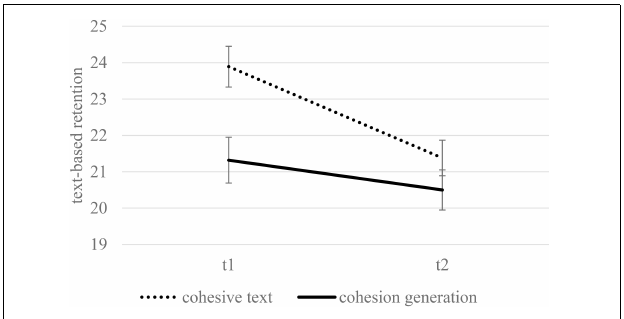
FIGURE 1 | Text based representation as a function of condition and delay when controlling for reading skills (estimated means and standard errors). Maximum performance was 38.